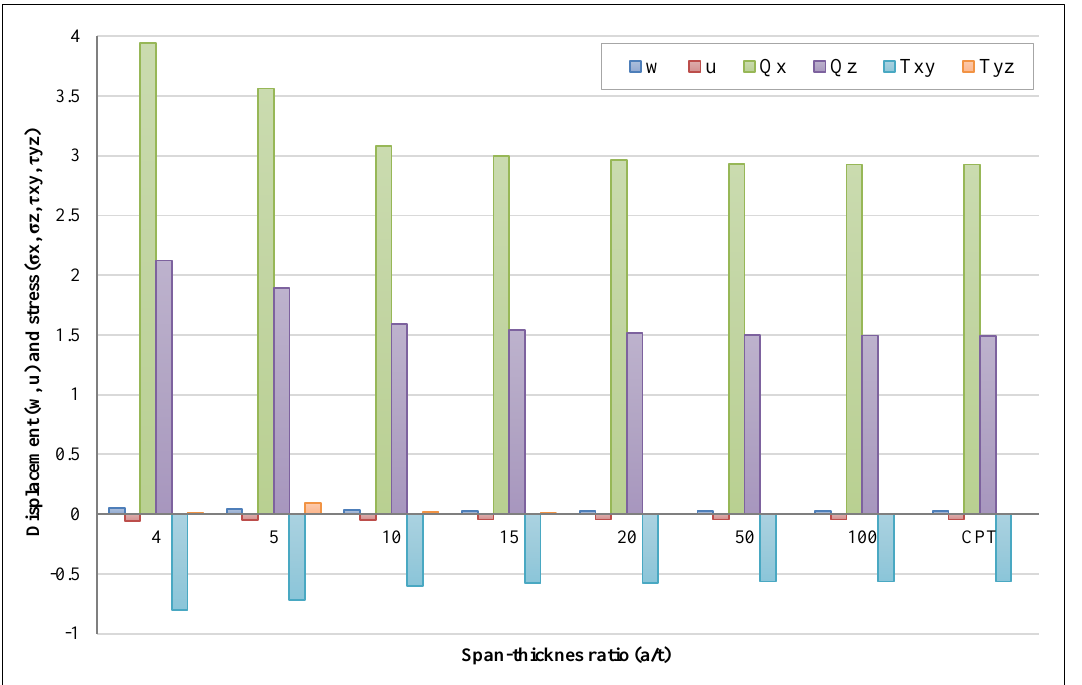
Figure 7, Displacement and stresses of a CCCC plate aspect ratio of